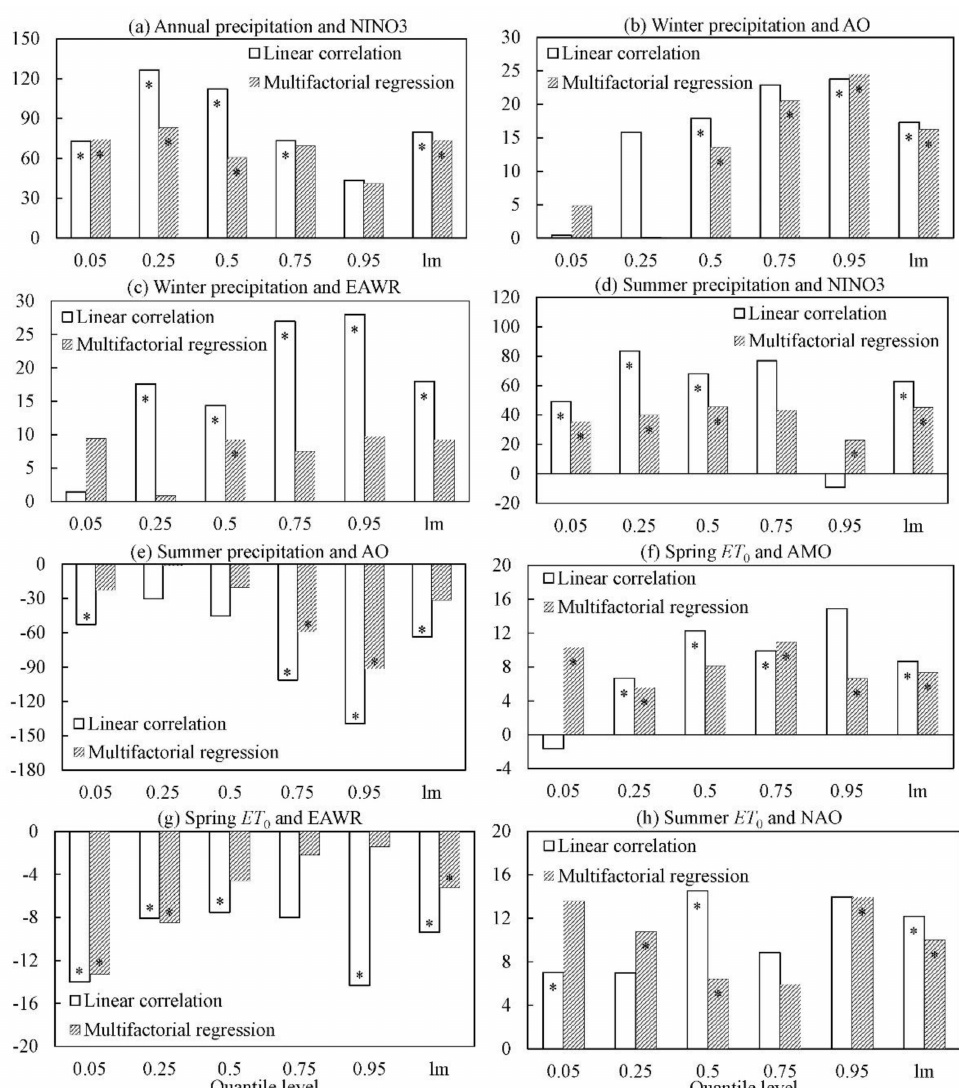
Figure 6. The regression coefficients between the series of precipitation and ET 0 and climate indices based on the frequentist quantile regression. * Statistically significant at the 0.05